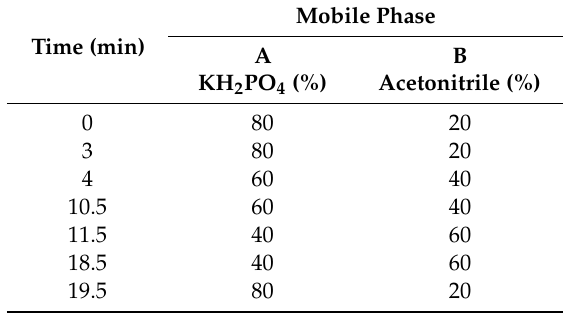
Table 2. Conditions of HPLC–diode array detector (DAD).